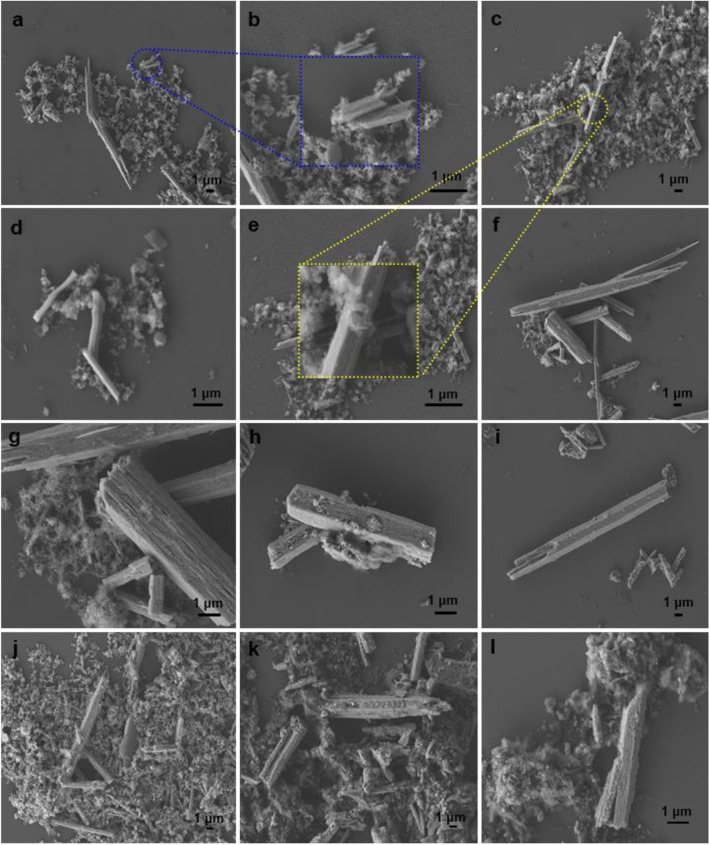
SEM images of (a) C1 (magnification of 5,000×), (b) C1 (20,000×), (c) C2 (5,000×), (d) C2 (15,000×), (e) C2 (20,000×), (f) C3 (3,000×), (g) C3 (10,000×), (h) C4 (10,000×), (i) C4 (4,300×), (j) C1g (5,000×), (k) C4g (5,000×), and (l) C4g (10,000×).